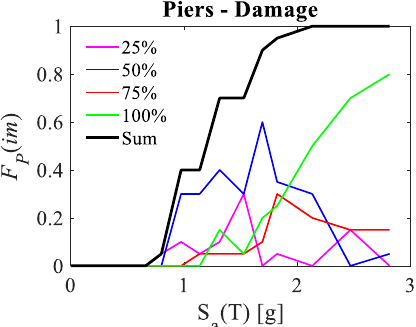
Figure 14. Type 2 quantitative fragility functions for piers: probabilities of occurrence of damage mechanisms for different percentages of involved piers at ( a ) damage; ( b ) life safety; and ( c ) collapse performance levels.